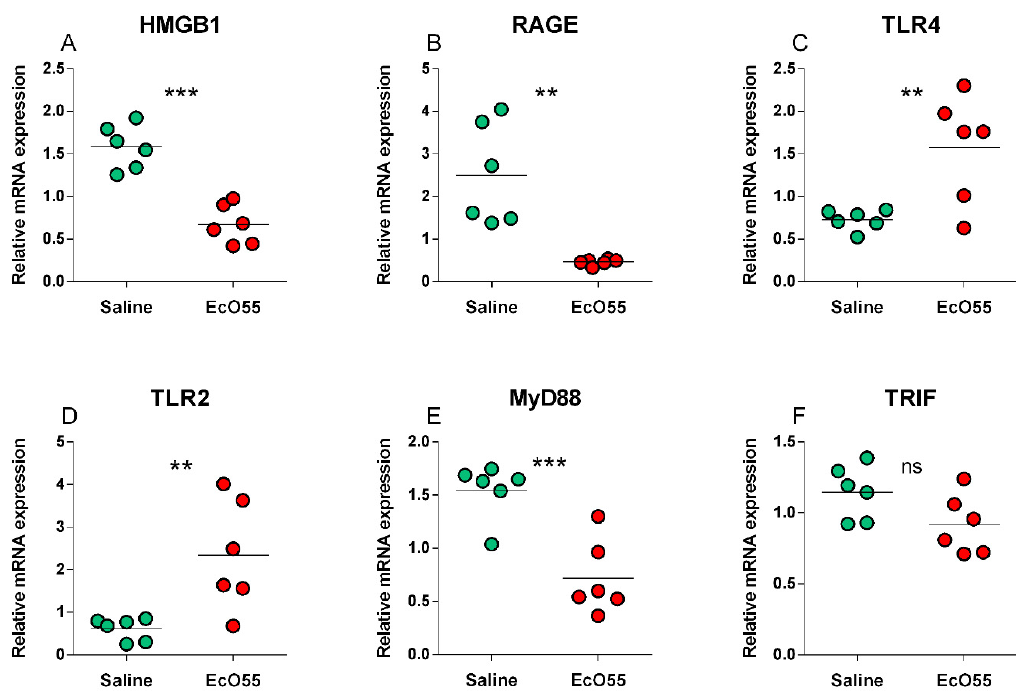
Figure 1. Relative mRNA expression (fold change) of HMGB1, RAGE, TLR2, TLR4, MyD88, and TRIF in the amniotic membrane. HMGB1 ( A ), RAGE ( B ), TLR4 ( C ), TLR2 ( D ), MyD88 ( E ), and TRIF ( F ) in the amniotic membrane of sham-infected (saline) and E. coli O55 (EcO55)-infected amniotic cavities. The individual values are depicted as green (saline) or red ( E. coli O55) dots, and the horizontal line represents the mean. Statistical differences were calculated by the unpaired two-tailed Student t-test and labelled as non-significant (ns) or significant p < 0.05 (*), p < 0.01 (**), p < 0.001 (***). Six samples in each group were analyzed.